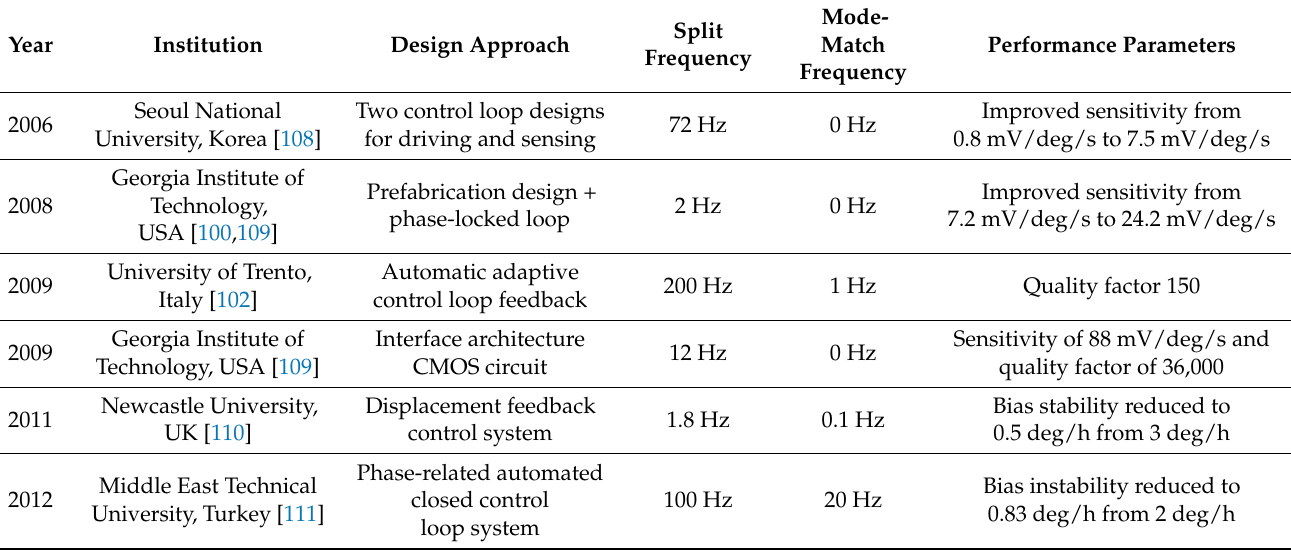
Table 4. Summary of different mode-matching techniques from some research